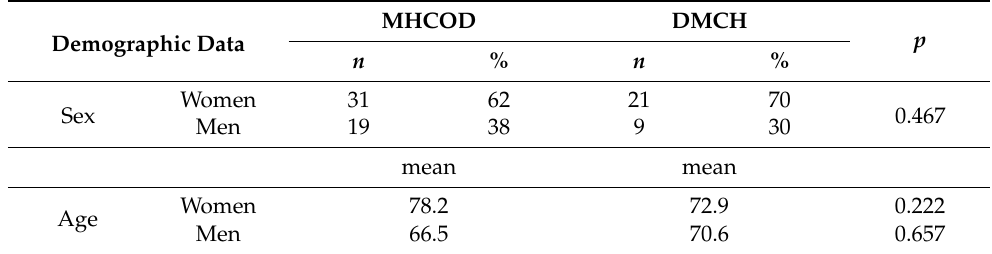
Table 1. Demographic data.